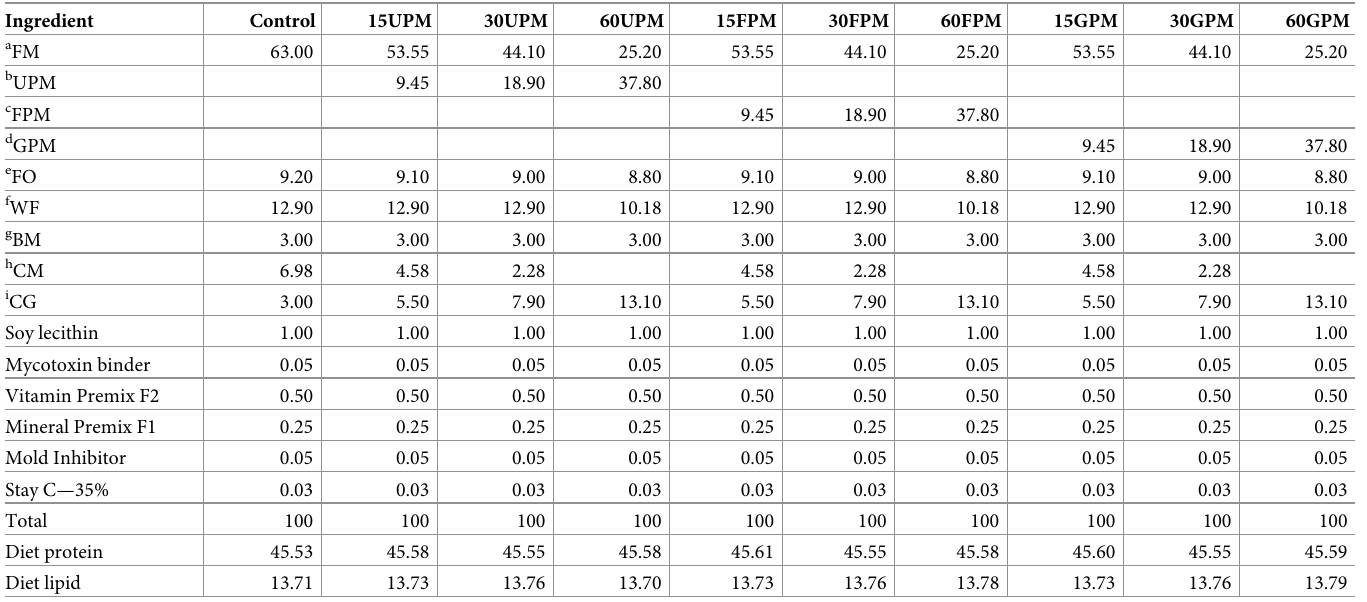
Table 1. Composition of control and test diets (FPM, Fermented Peanut Meal, GPM, Germinated Peanut Meal; UPM, Untreated Peanut Meal). Ingredient Control